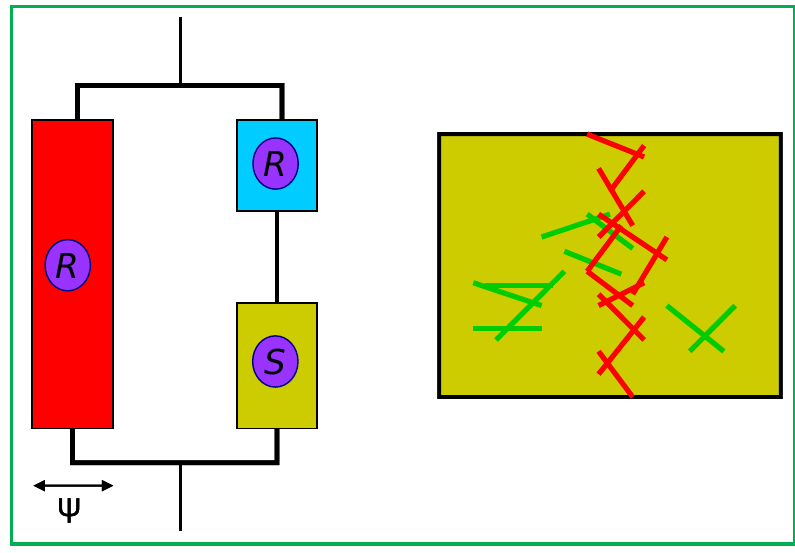
Figure 8. Schematic representation of the series parallel